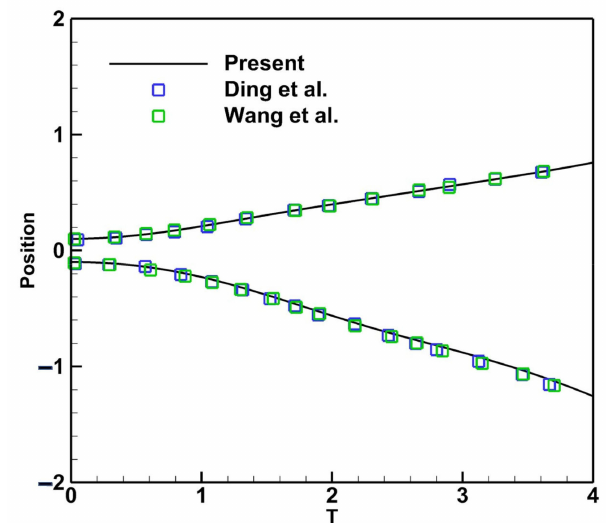
Figure 16. Interface positions of the bubble and spike for the Rayleigh–Taylor instability of Re = 3000 compared with references